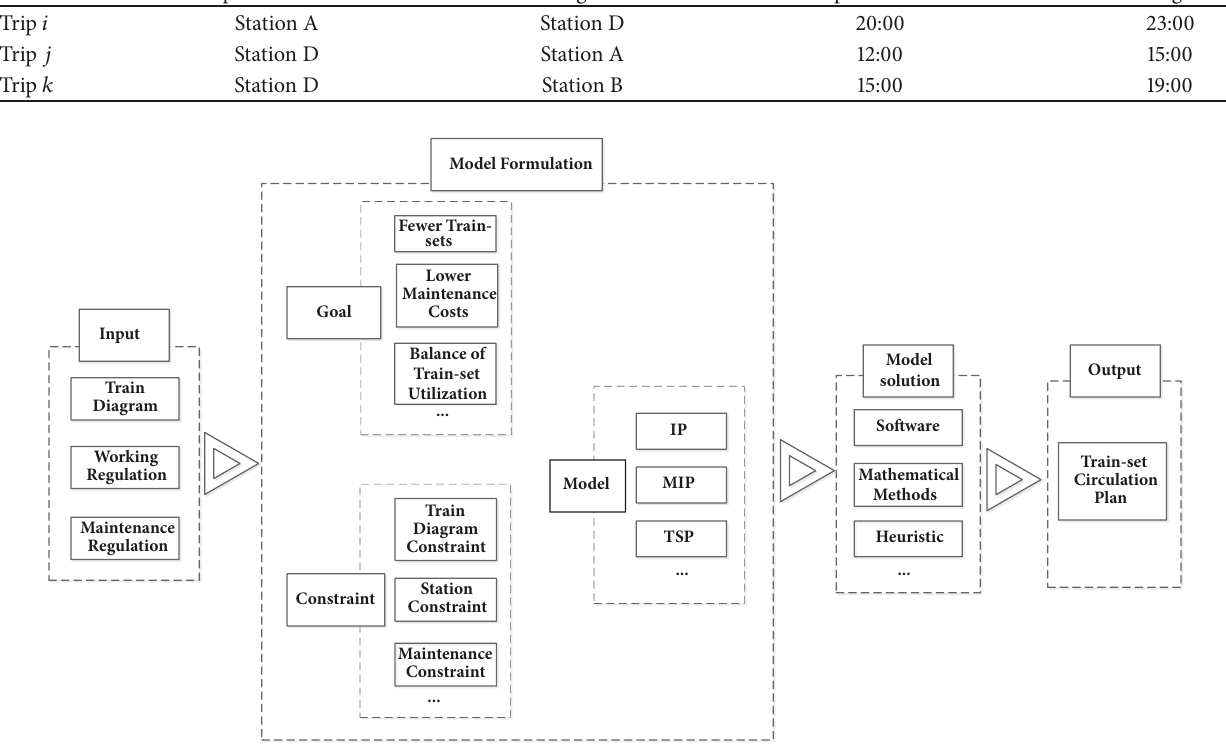
Figure 1: The outline of the TCP